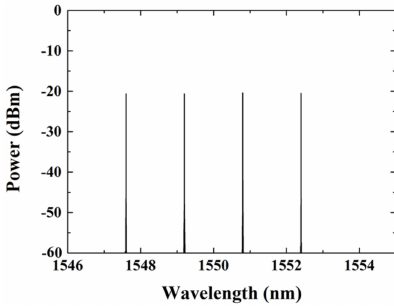
Figure 4. The spectrum of even signal wavelengths at output port 1 using the de-interleaver function.